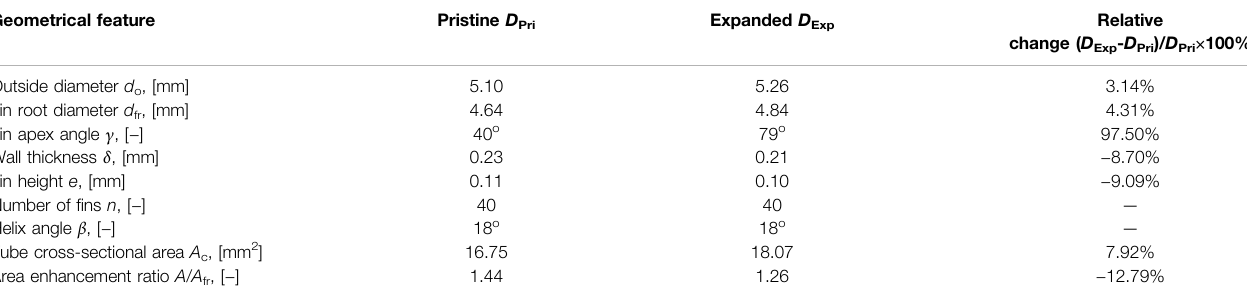
TABLE 2 | Micro- fi n tube